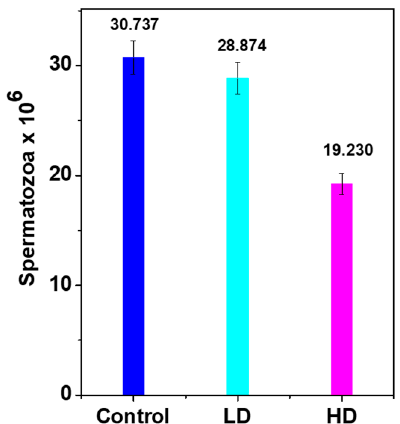
Figure 4. Daily sperm production / g of testis weight (DSP / g) in the control and TCS-treated pups. Results are presented as mean ± S.E.M. (n = 8). The means of DSP were significantly lower ( p < 0.05) in both treated groups vs. control.